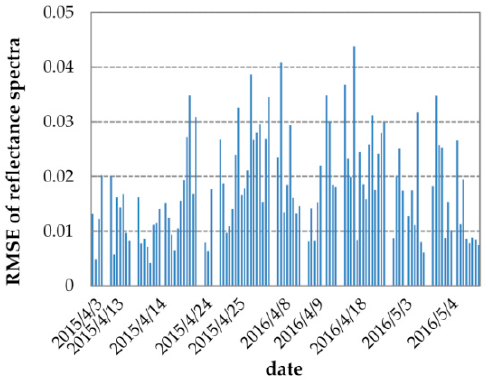
Figure 5. The simulated and measured reflectance spectra and their residuals at 10:00 for every fieldwork day in 2015 and 2016.